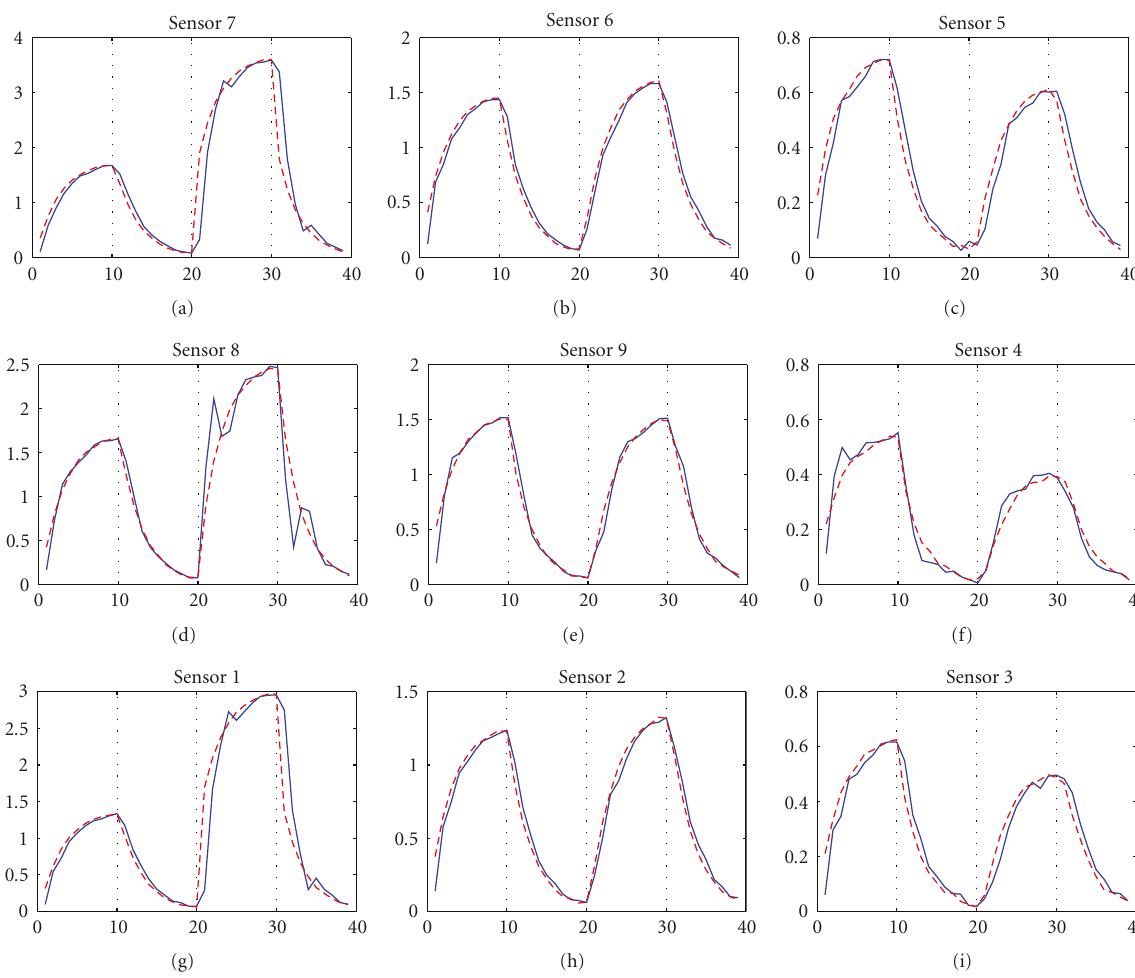
Figure 9: Evolution of the predicted (solid blue) and measured (dashed red) temperatures by each sensor. Both heat sources were turned on over the intervals [0,10] and [20,30], and turned o ff over [10,20] and [30,40]. Sensor locations can be found in Figure